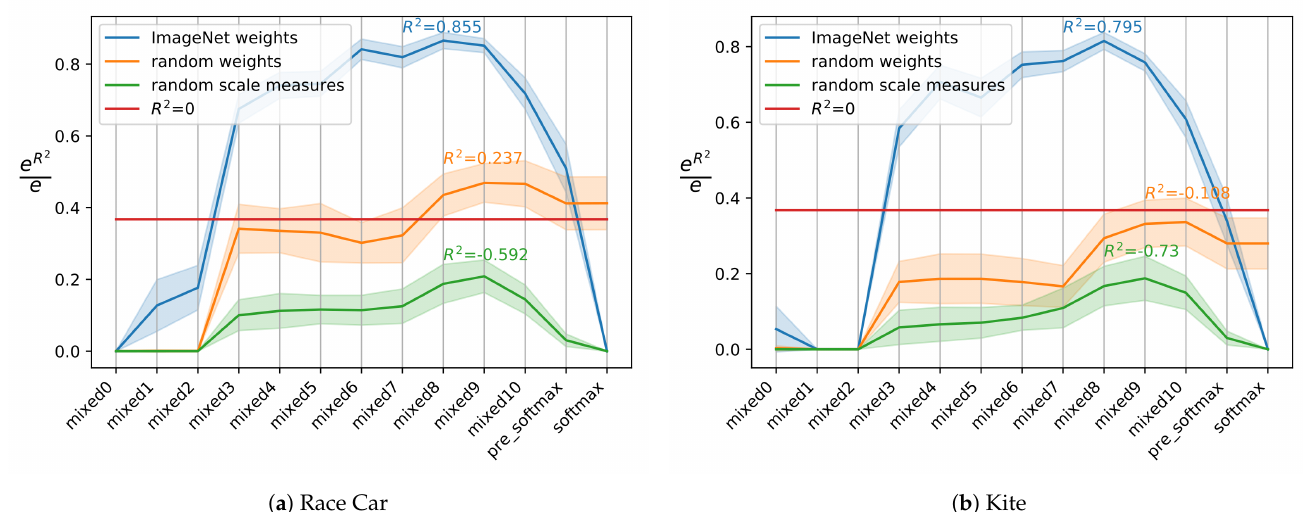
Figure 9. Comparison of regression (RCV) of scale measures at different InceptionV3 layers on the two classes ( a ) race car (ID: n04037443) and ( b ) kite (ID: n01608432). The regression is evaluated as the e R line R 2 = 0 show a predictive regression better than the average of the scale ratios r . Average and standard deviations are reported for 25 runs.